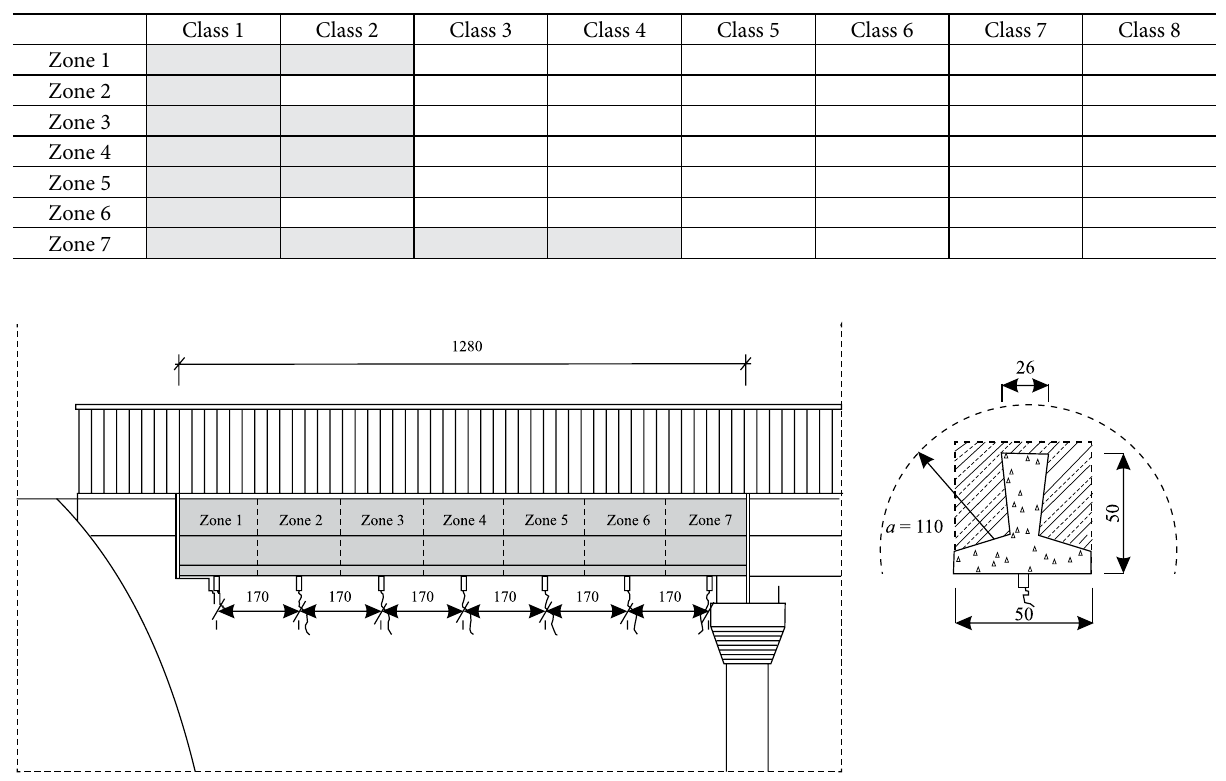
Table 2. Classes of signals (damage processes) registered in different measuring zones of one of the bridge beams under service load